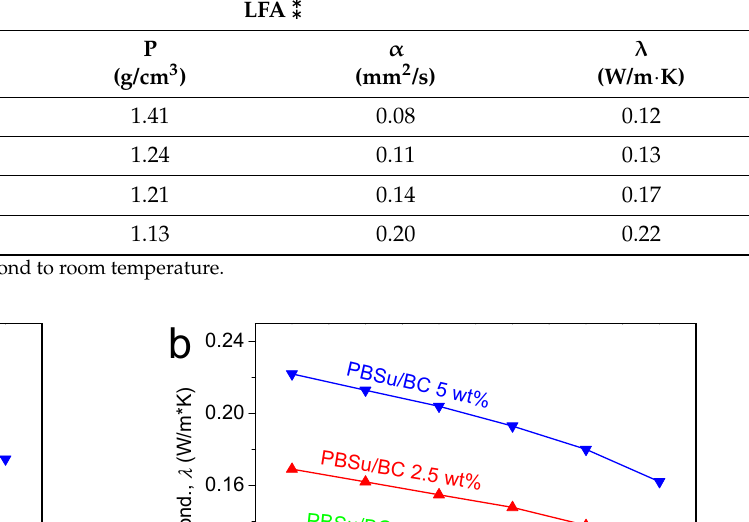
Figure 7. The temperature dependence of ( a ) thermal diffusivity, α , and ( b ) thermal conductivity, λ , for all samples (compositions).